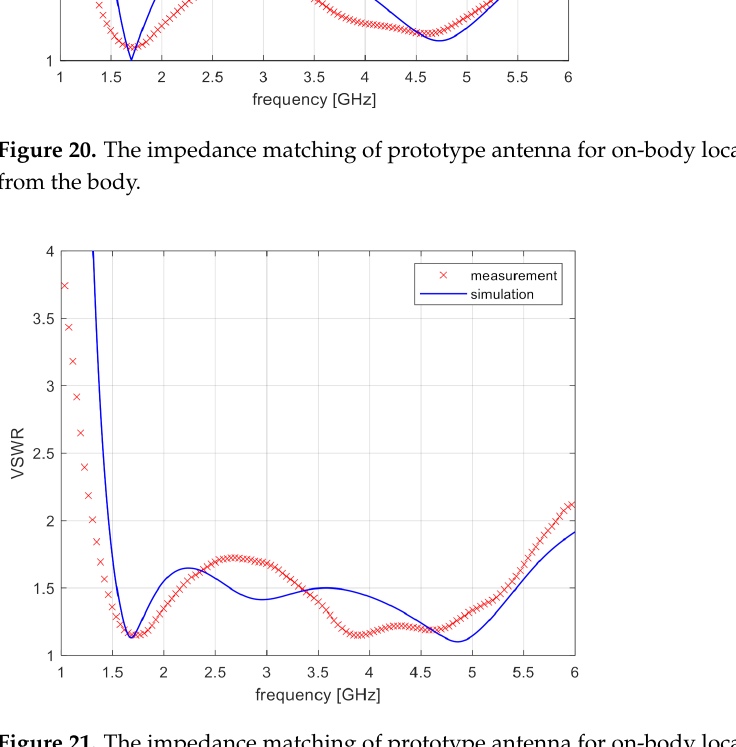
Figure 21. The impedance matching of prototype antenna for on-body location for 30 mm distance from the body.